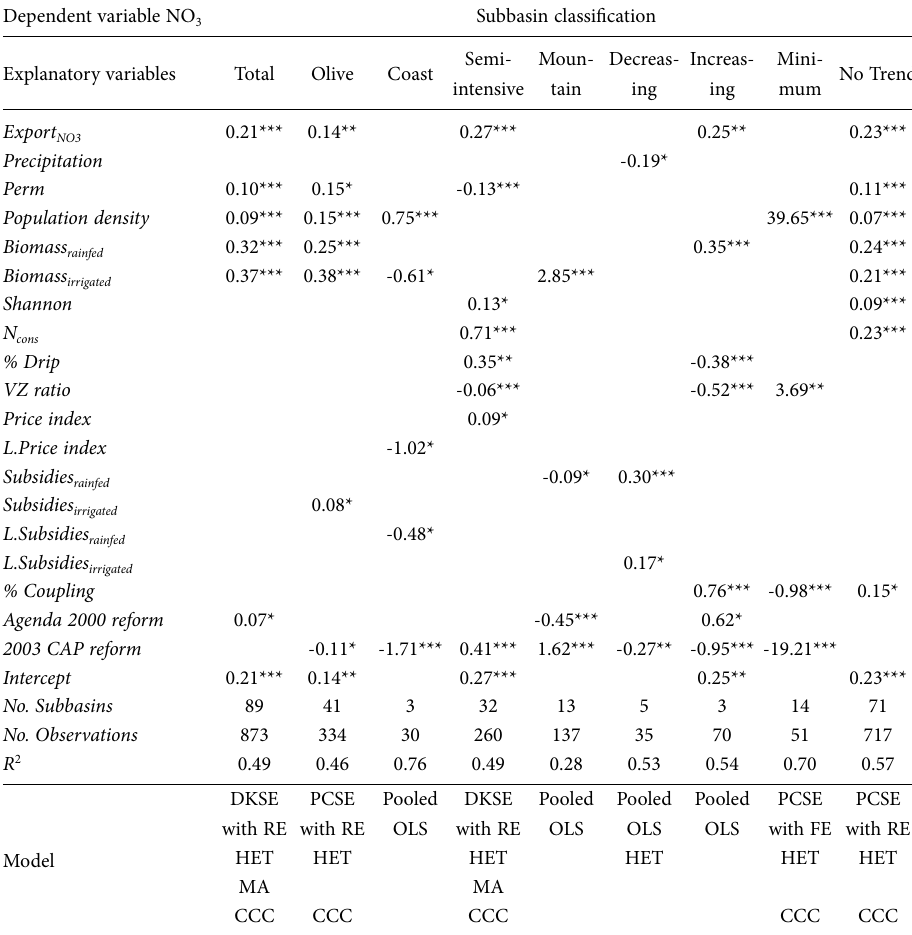
Table 5. Panel data regressions for nitrates (NO 3 ) considering all the subbasins (Total), by type of agri- culture (Olive, Coast, Semi-intensive and Mountain) and by existing time trend (Decreasing, Increasing, Minimum and No Trend). The regression models include significant variables (p<0.05)